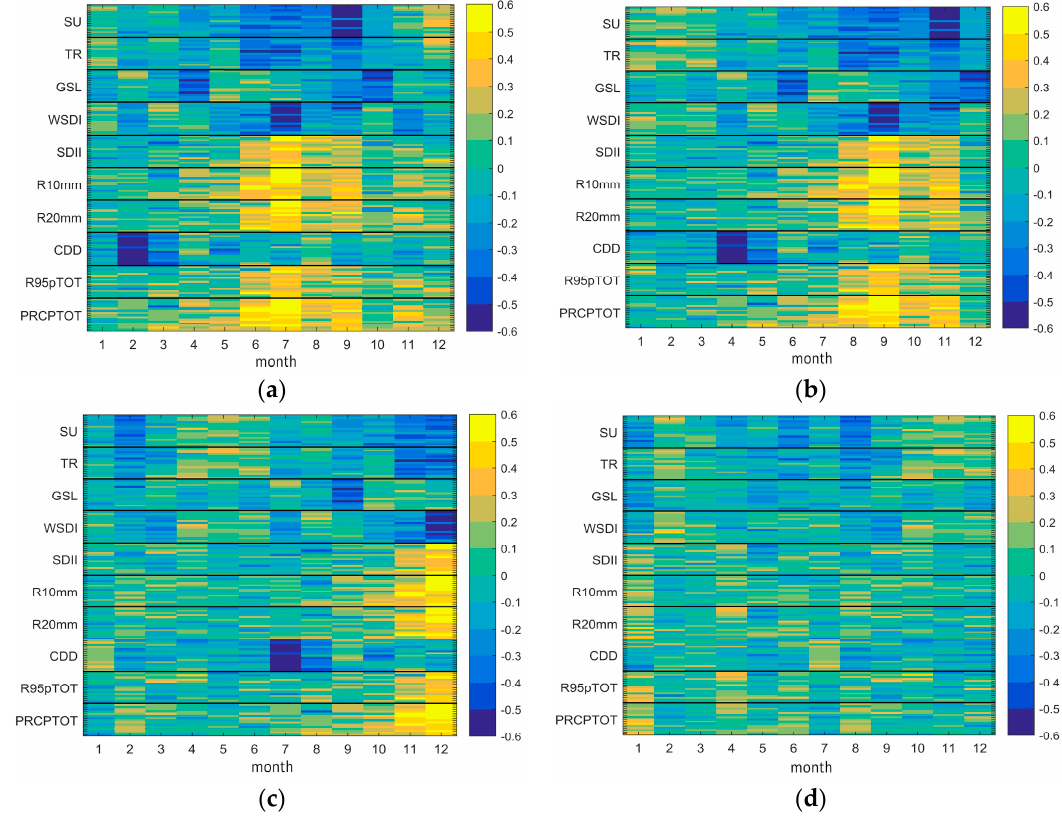
Figure 6. Correlation coefficients between indices of climate extremes and SPEI ‐ 1 ( a ); SPEI ‐ 3 ( b ); SPEI ‐ 6 ( c ); and SPEI ‐ 12 ( d ) in Horqin Sandy Land during 1964–2013